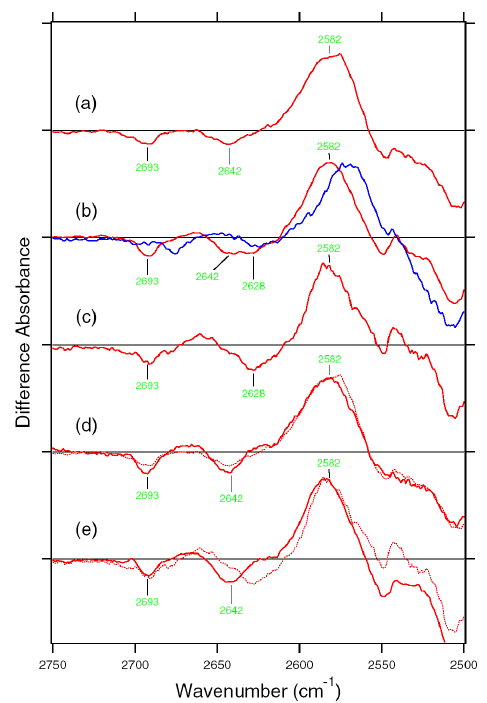
Figure 37. The ASR minus ASR infrared spectra of the wild type at pH 5 (a), pH 7 (b), L and pH 9 (c), E36Q at pH 5 (d) and pH 9 (e) in the 2,750–2,500 cm -1 region on red